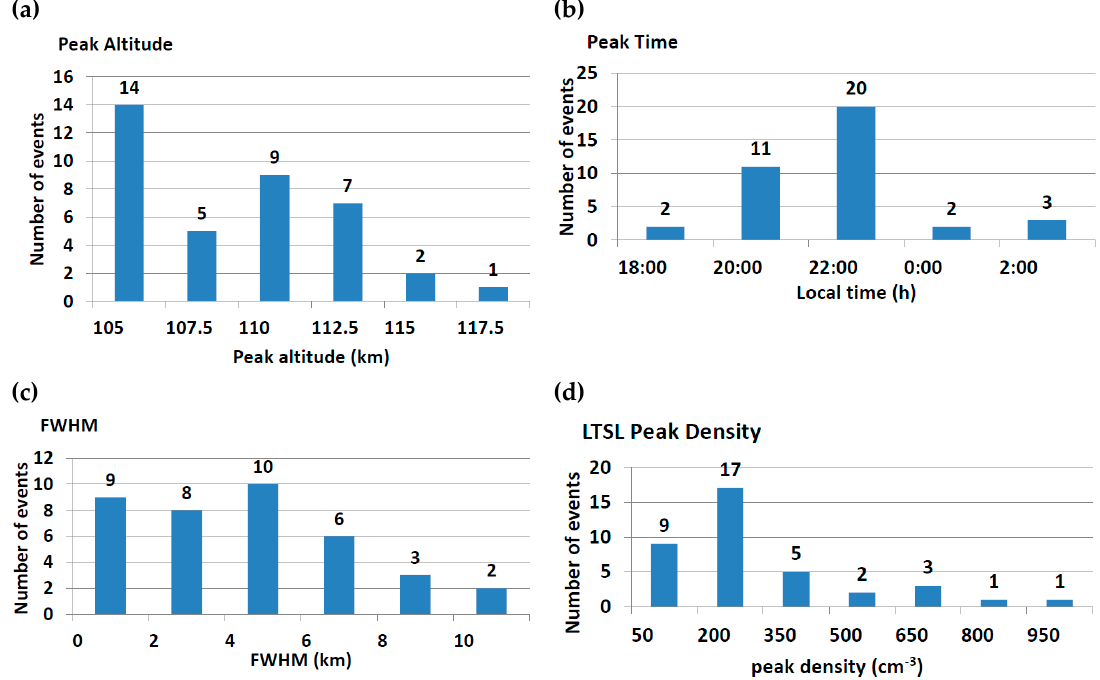
Figure 2. Histogram of ( a ) peak altitudes, ( b ) peak times, ( c ) full width at half maximums (FWHMs), and ( d ) peak densities of LTSLs.